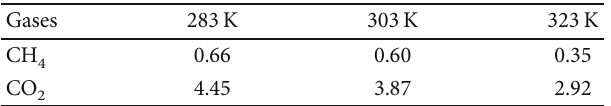
Table 6: Results of Henry ’ s constant for CO temperatures on